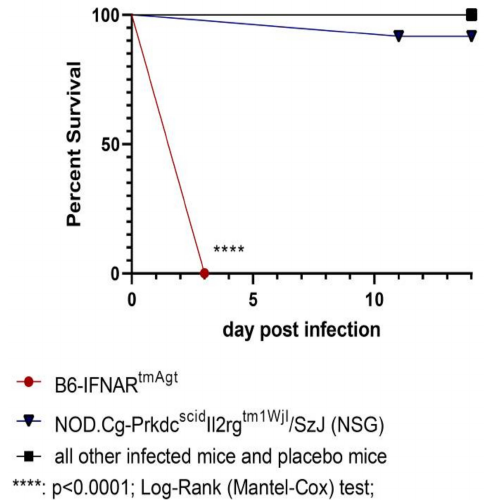
Figure 1. Kaplan–Meier survival curve of all mouse strains infected with RVFV and placebo groups: B6-IFNAR tmAgt mice died or were euthanized three days after subcutaneous RVFV infection. Except for 1/12 (8%) of the NSG mouse, all other mice survived until the end of the study after subcutaneous RVFV infection. The surviving groups are summarized for better readability. RVFV: Rift Valley fever